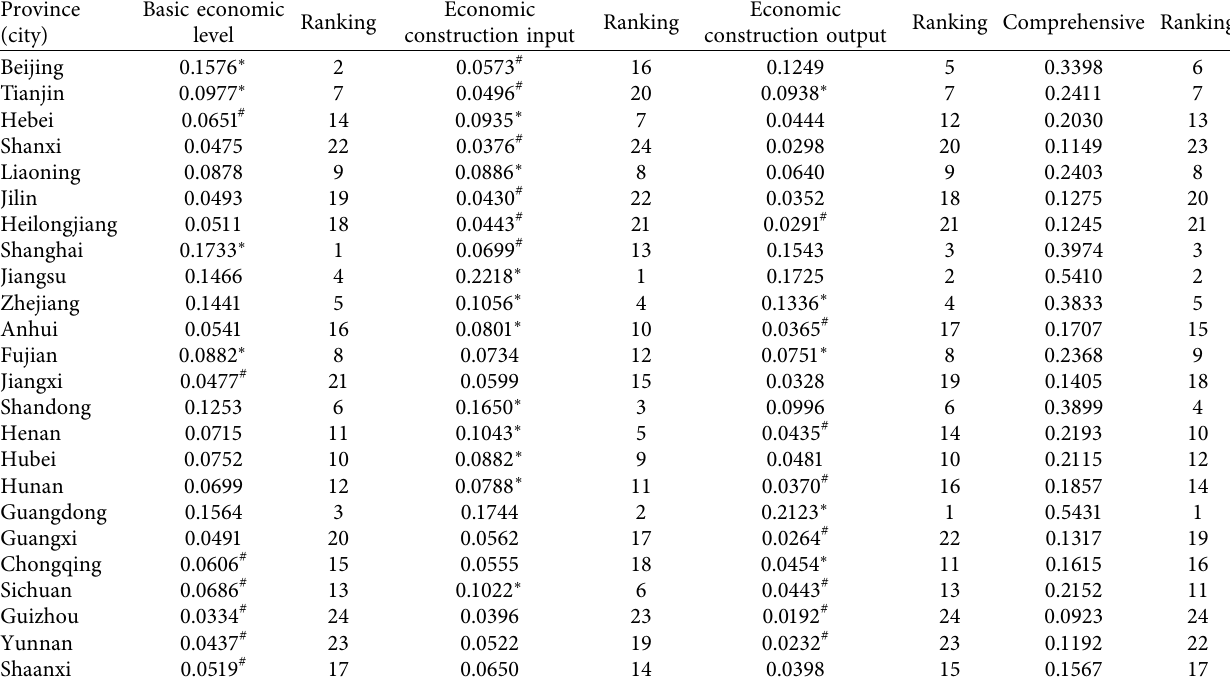
Table 6: Average value and ranking of regional economic development level of Chinese provincial (municipal) from 2009 to 2018.